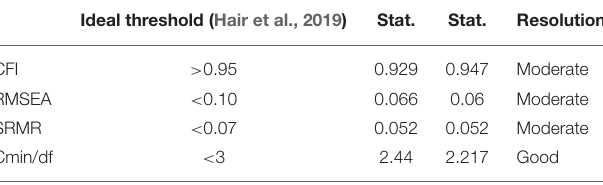
TABLE 8 | Statistics on variation reflected by factors extracted with CATPCA. Ideal threshold (Hair et al., 2019) Stat.